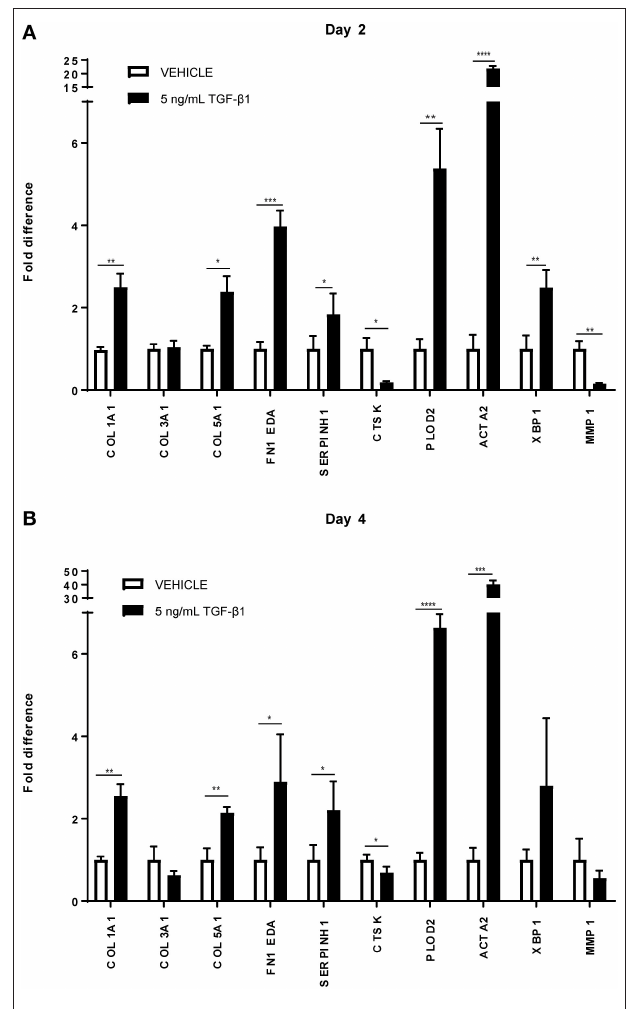
FIGURE 1 | Relative mRNA expression of fibrosis markers in human dermal fibroblasts ( n = 4) under TGF β 1 stimulation. mRNA expression of COL1A1, COL3A1, COL5A1, FN1 EDA, SERPINH, PLOD2, ACTA2, XBP1, MMP1, and CTSK in human dermal fibroblasts with 5ng/mL TGF β 1 stimulation